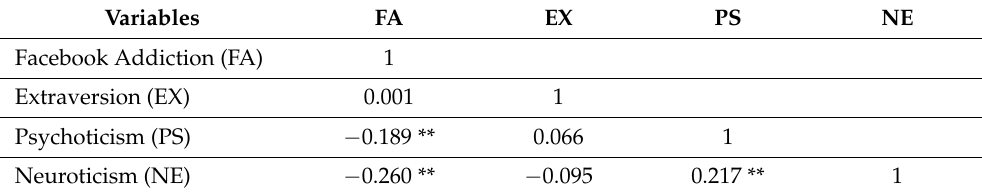
Table 1. Correlation Matrices for Facebook Addiction and Personality Traits. Variables